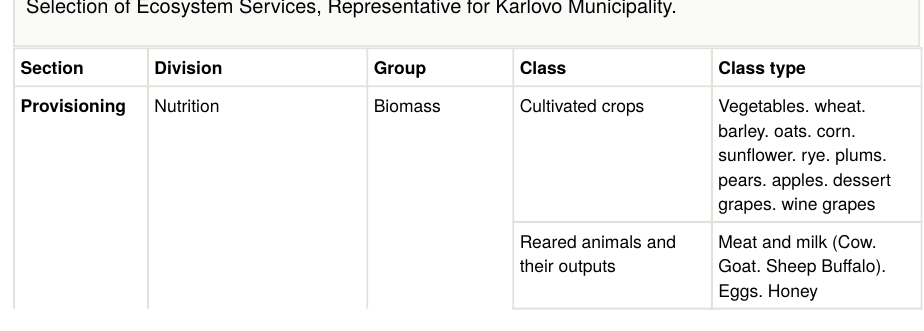
Selection of Ecosystem Services, Representative for Karlovo